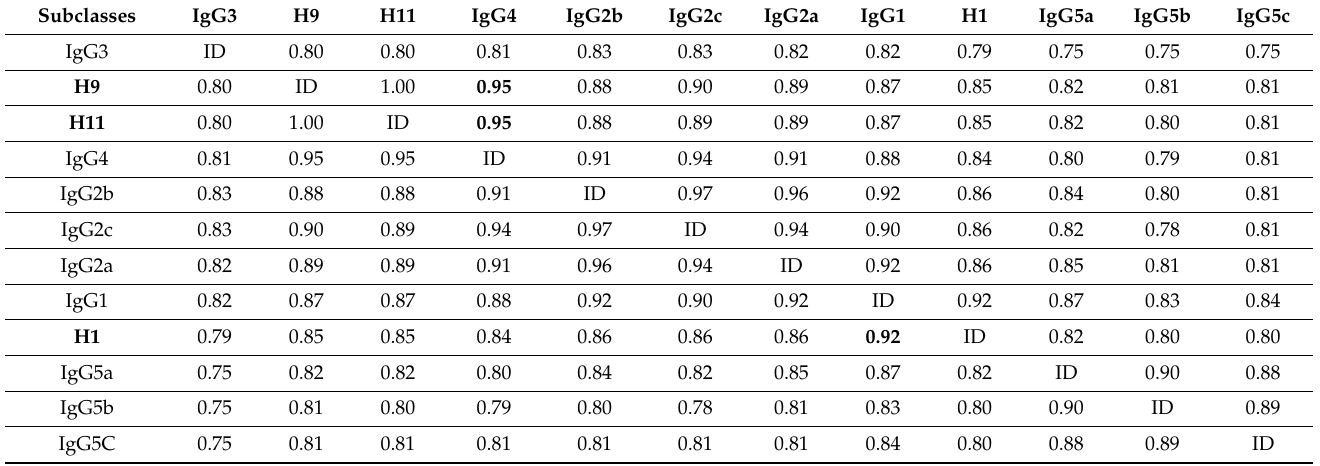
Table 2. Amino acid sequence identity matrix of H1, H9 and H11 constant regions with known pig IgG subclasses.